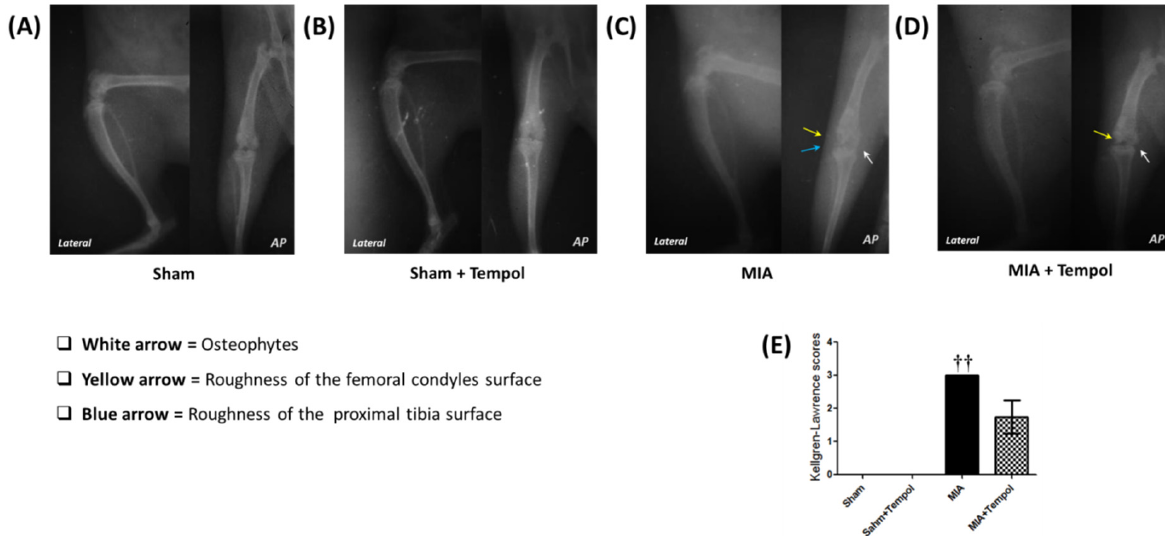
Figure 7. Effect of Tempol on representative X-ray radiographs. Normal radiographs were revealed in the sham group ( A ) and Sham+Tempol group ( B ) along the hip-knee-ankle (HKA) axis. However, the images of the MIA-induced OA group ( C ) showed increased joint opacity, and osteophyte formation (white arrow) associated with rough surfaces of the femoral condyles and proximal tibia (yellow and blue arrow). On the other hand, the X-ray images of the tempol post-treated group ( D ) showed almost normal joint space with little lysis of the femoral articular surface (yellow arrow) and few osteophytes (white arrow). Where AP view is the anterior-posterior view (Flexion angle 10 ◦ ), and lateral view (Flexion angle 30 ◦ ). Panel ( E ) represents the means of the Kellgren-Lawrence (K-L) scoring system (Score range: 0–4), where the statistical analysis was carried out using Kruskal-Wallis test followed by Dunn’s post-test. Results are expressed as mean ± SD ( n = 4). †† p < 0.01 vs. the sham